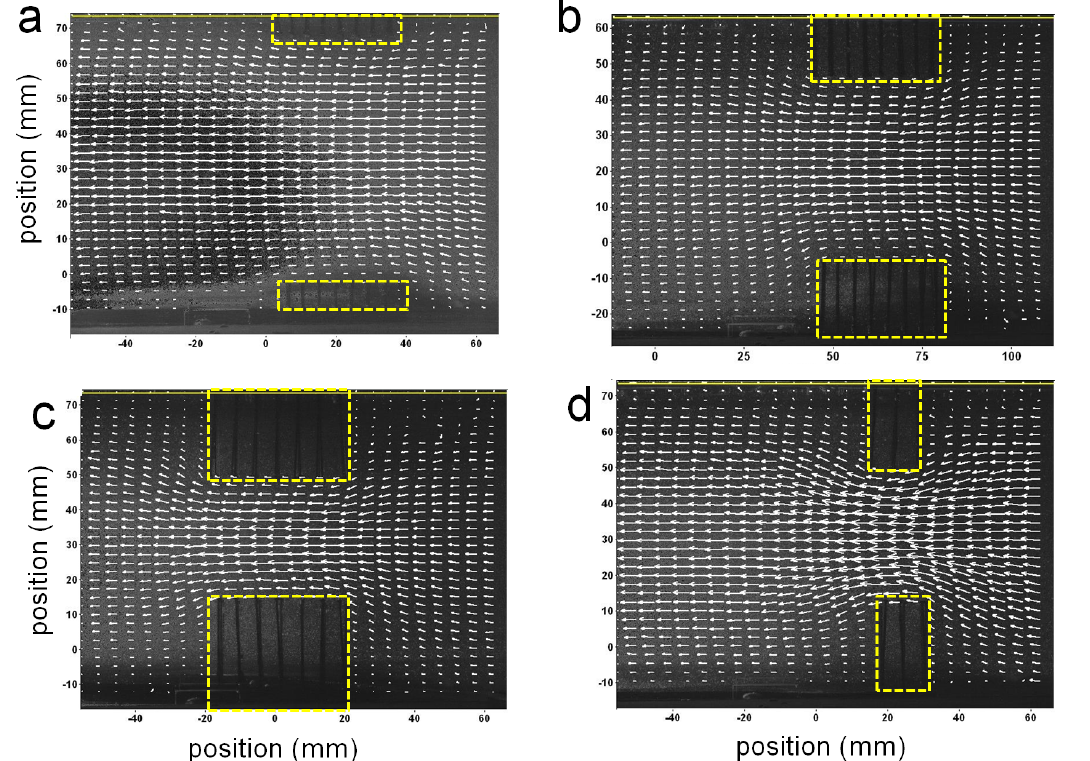
Figure 4. Some example velocity vector fields obtained from particle image velocimetry (PIV) measurements of the flow around the physical models from the side view. The lengths of the vectors are proportional to the magnitude of the velocity. Flow is from right to left. The background of the images are snapshots of the flow. The regions where the model pins are located are enclosed by yellow boxes. In ( a – c ) the length of the layer was kept constant, while the height was varied, while in ( d ) the length was decreased and the height was equal to that of ( c